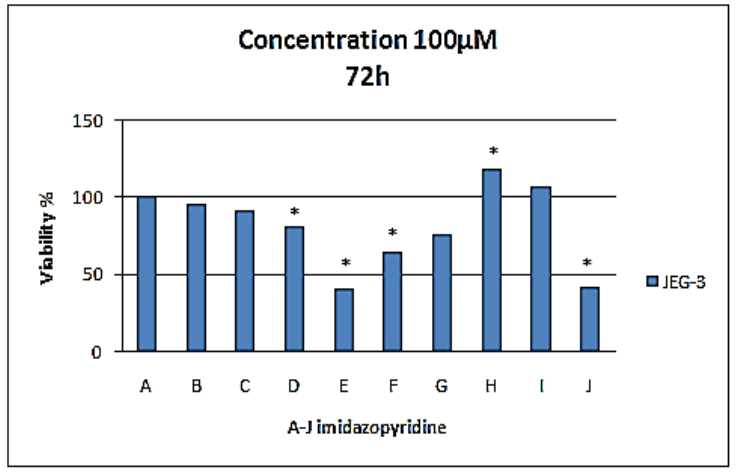
Figure 4. Effect of steroidal imidazoheterocycles A – J